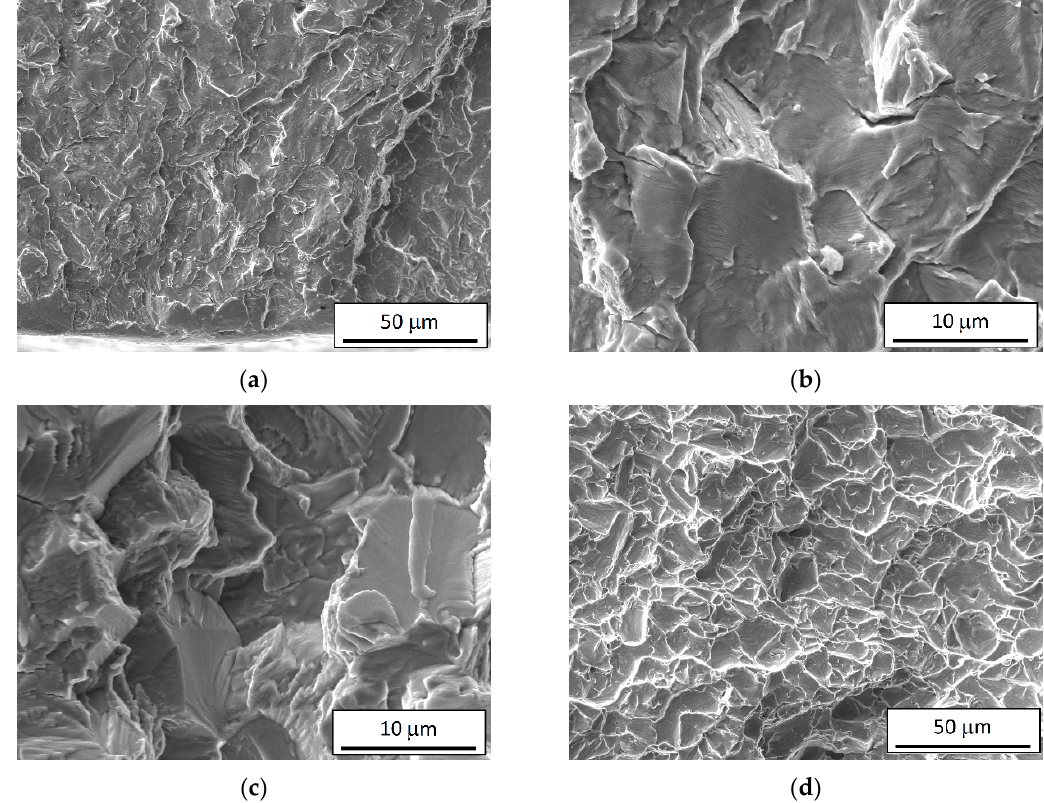
Figure 19. Fractographic analysis of the as-received titanium Grade 4 specimen after fatigue testing: ( a ) fatigue crack initiation site, ( b ) striations, ( c ) quasi-cleavage, ( d ) final fracture region.